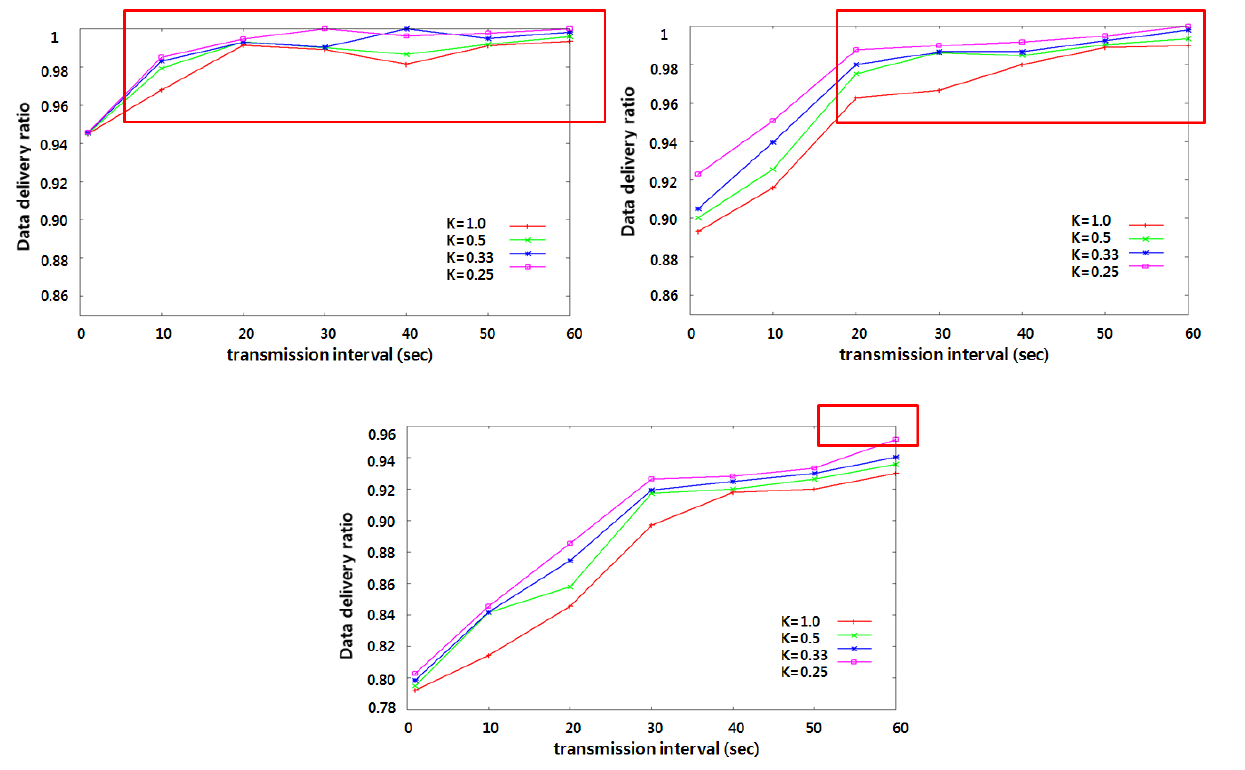
Figure 6. Data delivery ratio with increasing the transmission interval. (a) 30 hops-sized network topology (b) 50 hops-sized network topology (c) 70 hops-sized network